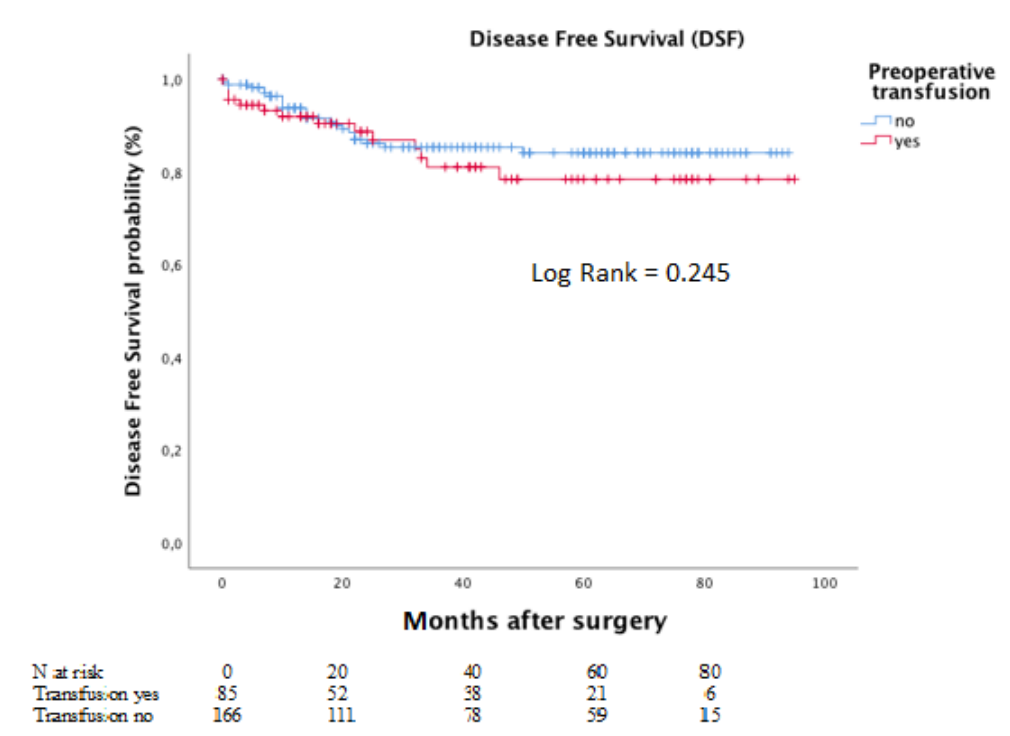
Figure 4. Disease-free survival according to preoperative transfusion in moderate to severe anaemic patients. Table 4. Multivariate analysis for overall survival ( A ) and disease-free survival ( B ) in patients with moderate to severe